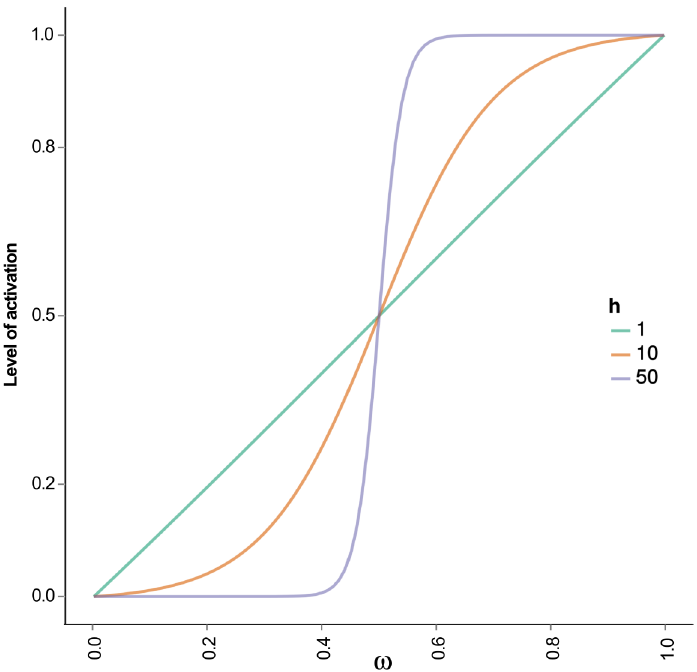
Fig 6. The activation part of Eq (1) is a sigmoid function of the total input of the node ( ω i ) Regardless of the value of h , the sigmoid touches the points (0,0), (0.5,0.5) and (1,1). For values of h (cid:4) 50 the curve resembles a step